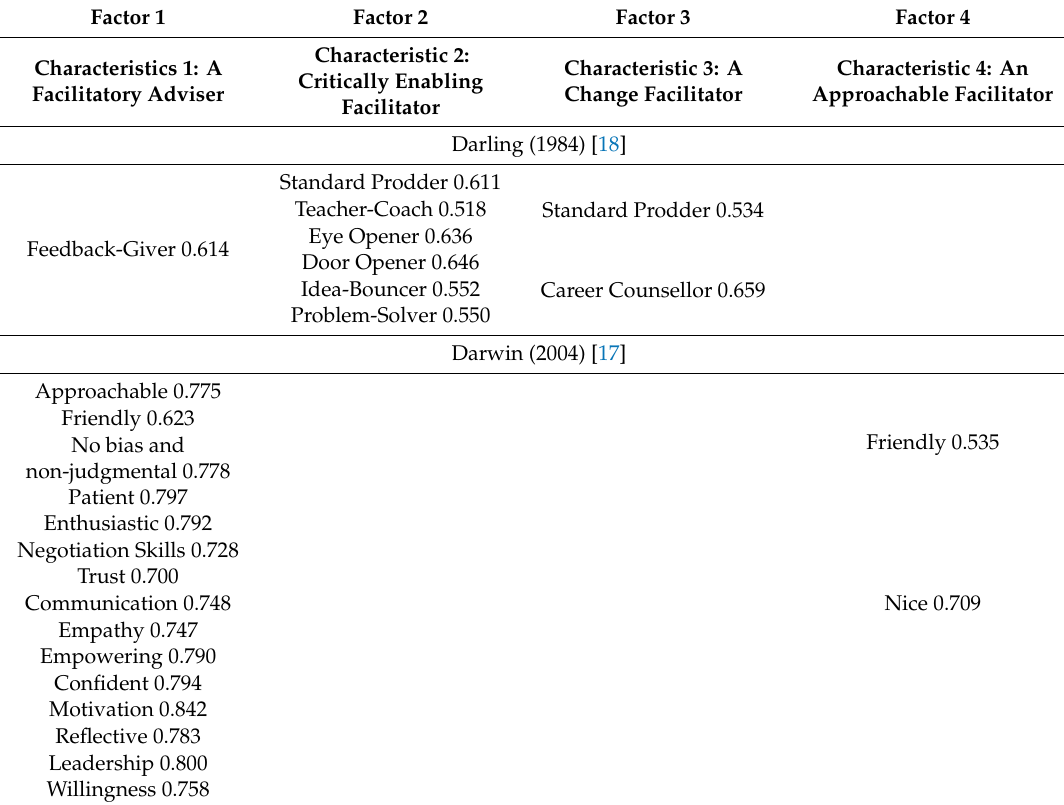
Table 4. Emerging characteristics and labeling of factors following principal